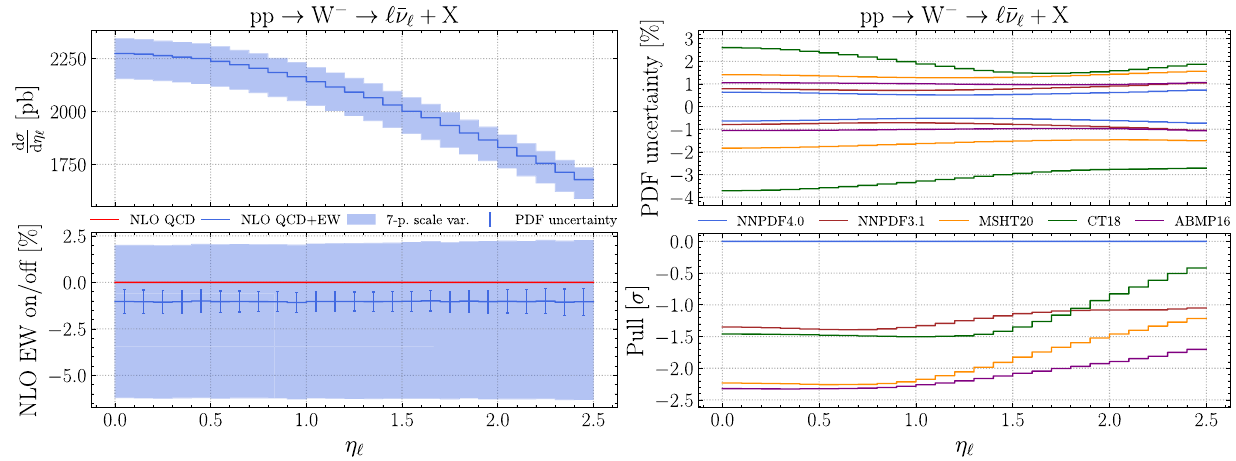
Fig. 63 The differential distribution in charged lepton rapidity, η (cid:5) , for inclusive l ¯ ν (cid:5) production. Note that the result of a fully off-shell calculation is presented; the heading in the plot indicates the domi- nant W − intermediate state. Predictions obtained using NNPDF3.1, NNPDF4.0, CT18, MSHT20, and ABMP16 are compared. We show the NNPDF4.0 absolute cross-sections (top left) with the band indicat-